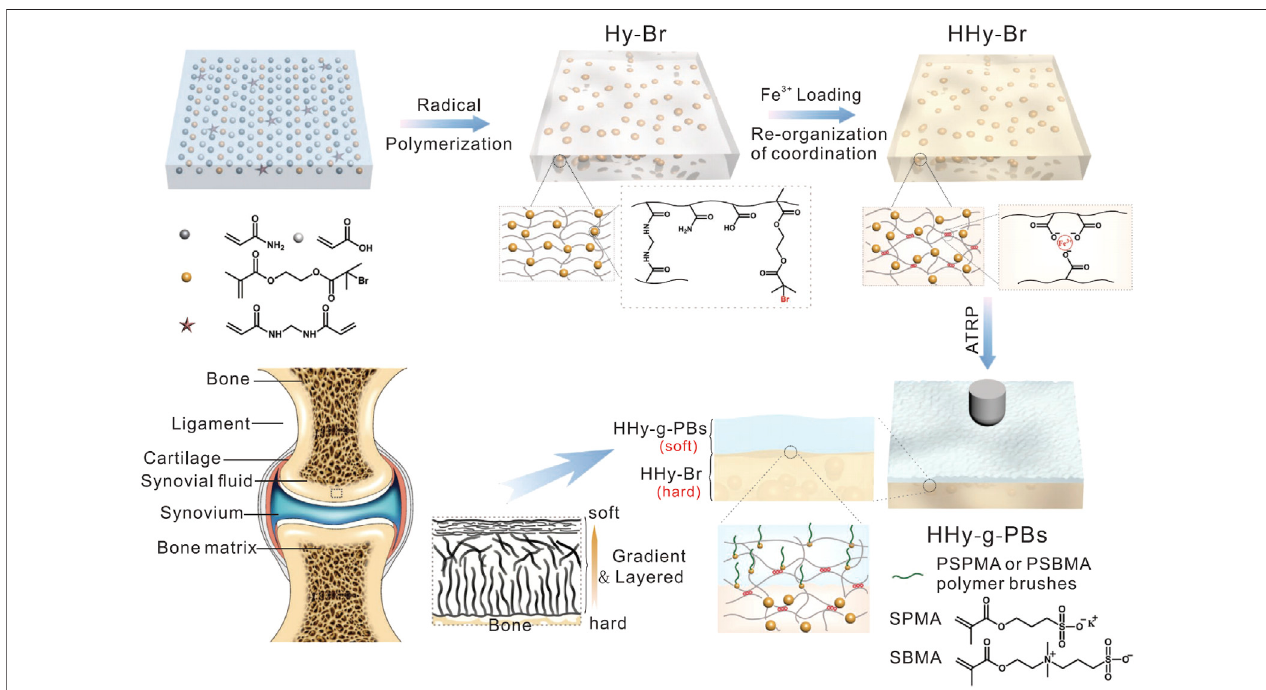
FIGURE 4 | Schematic of cartilage-like hydrogel. Illustration of fabrication procedures of PSPMA or PSBMA brush-grafted hydrogels. The high-strength hydrogel substratewithembeddedBrMAwasfabricatedbyradicalpolymerizationandpost-treatmentwithferricions.Subsequently, thelayerofpolymerbrush – graftedhydrogel (HHy-g-PBs) was prepared by the ATRP method at the subsurface. Combining the soft HHy-g-PBs layer with a strong HHy-Br substrate could mimic the structure of articular cartilage. Reproduced with permission from Rong M. et al., Adv Funct Mater ; published by Wiley-VCH, 2020.